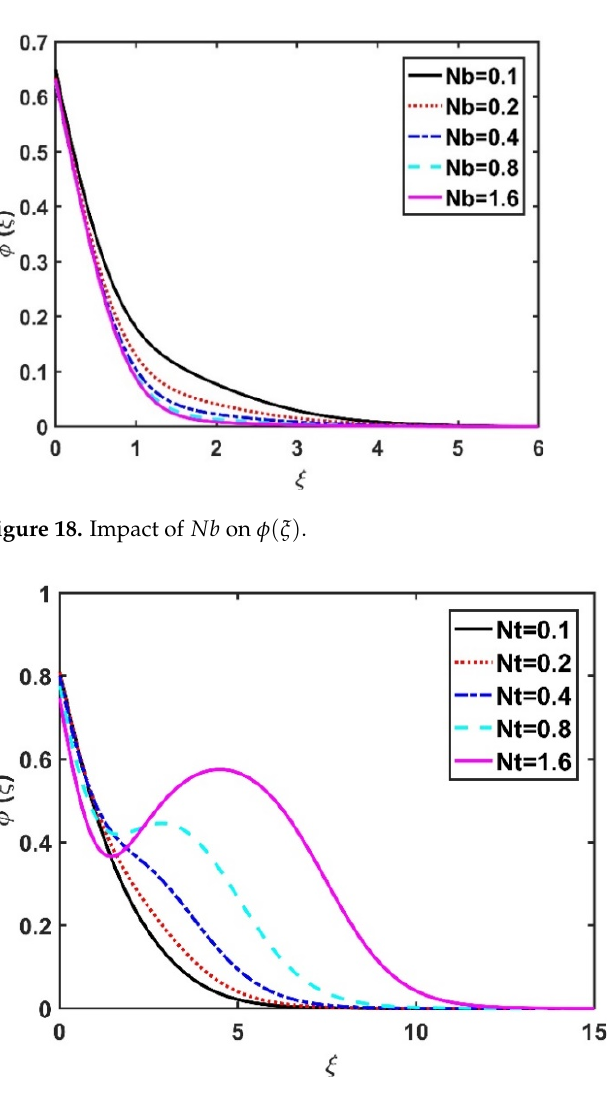
Figure 20. Impact of 𝛼 (cid:2871) on 𝜙(cid:4666)𝜉(cid:4667) . Figure 21. Impact of 𝐿𝑒 on 𝜙(cid:4666)𝜉(cid:4667) . 4.4. Motile Microorganism Profile ( 𝛹(cid:4666)𝜉(cid:4667) ) Figures 22 and 23 illustrate the motile microorganism distribution Ψ(cid:4666)𝜉(cid:4667) with respect to the magnetic number (cid:4666)𝑀(cid:4667) and the Hall number (cid:4666)𝑚(cid:4667) , respectively. The Ψ(cid:4666)𝜉(cid:4667) profile decreased with an increase in the Hall factor (cid:4666)𝑚(cid:4667) , while it improved with a rise in the 𝑀 value. Physically, the Lorentz force facilitates the increased diffusivity of